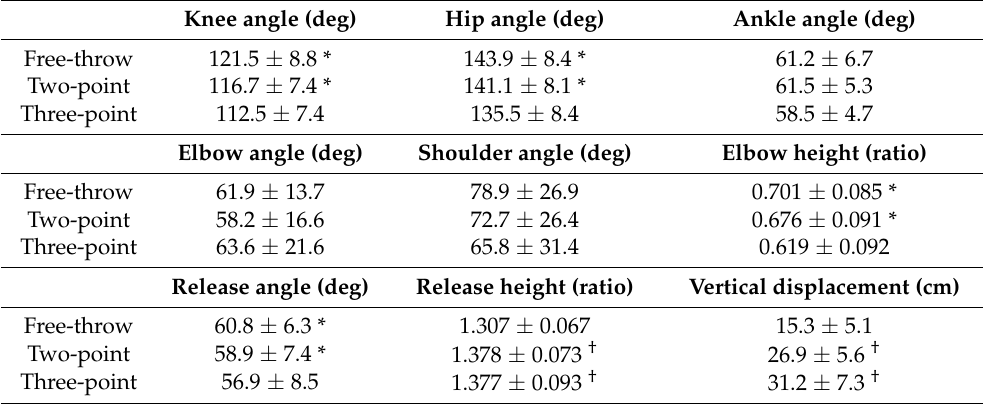
Table 1. Descriptive statistics, means and standard deviations (x ± SD), for each dependent variable observed for free-throw, two-point, and three-point shooting